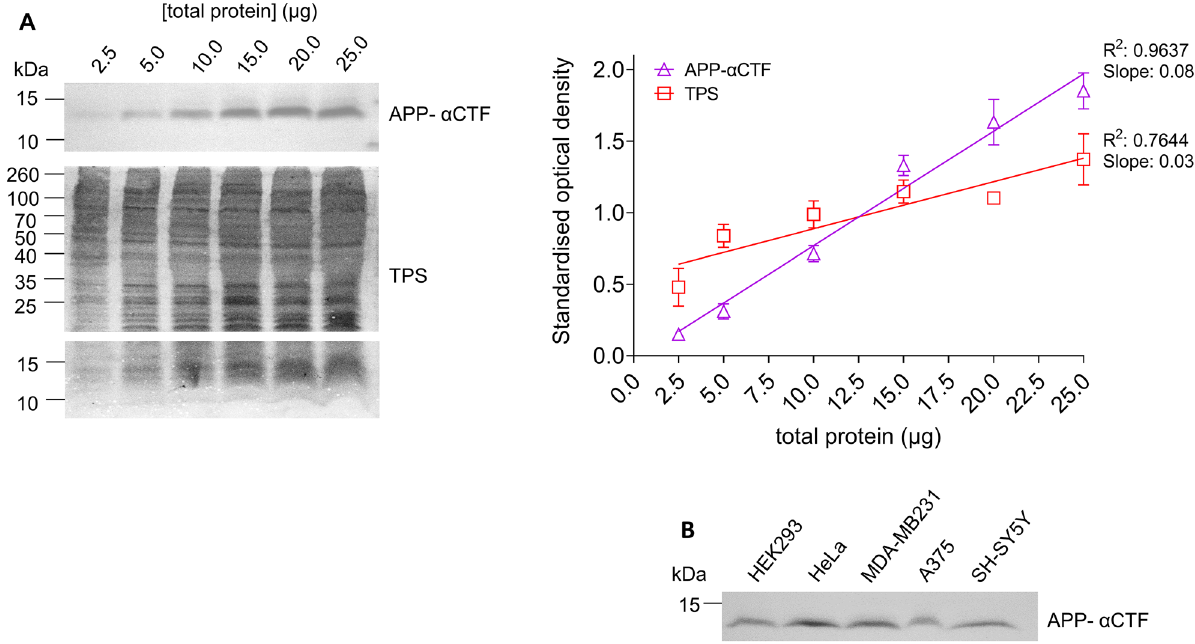
Figure 1. The detection of APP-αCTF in relation to protein concentration, and in five common mammalian cell lines. ( A ) Western blot analysis of HEK293 cell lysate with APP-αCTF detection as total protein concentration increases (2.5–25 µg) as compared to amido black total protein stain (TPS) with corresponding standardised optical density plots as analysed for APP-αCTF (open purple triangle) and TPS (open red square) as mean ± SD showing R 2 and slope for each (n = 3). ( B ) Western blot analysis of cell lysates from HEK293, Hela, MDA-MB-231, A375 and SH-SY5Y cell lines showing detection of APP-αCTF (10 µg total protein loaded/well). Cropped western blots are shown—see supplementary information file, raw data images for full-length western